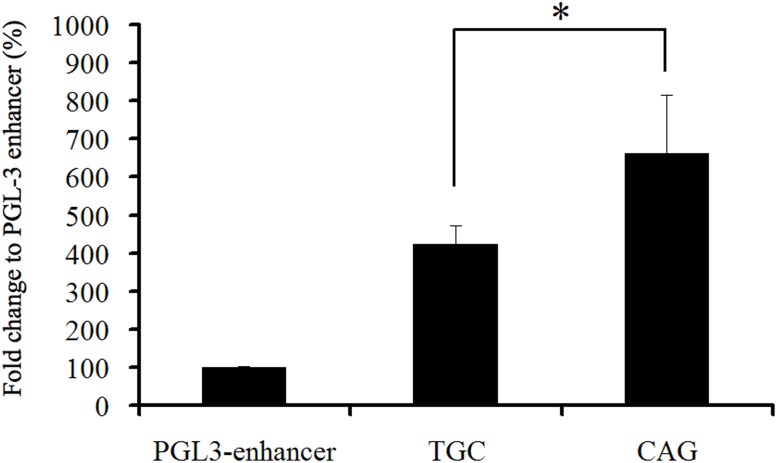
Reporter gene activity assay of two haplotypes of GABRB3 in this study.The haplotype C-A-G had a significantly higher promoter activity than haplotype T-G-C. The pGL-3 enhancer was an empty vector that did not contain the insert of interest, whose activity was used as background activity in this study. (* indicates p<0.01).